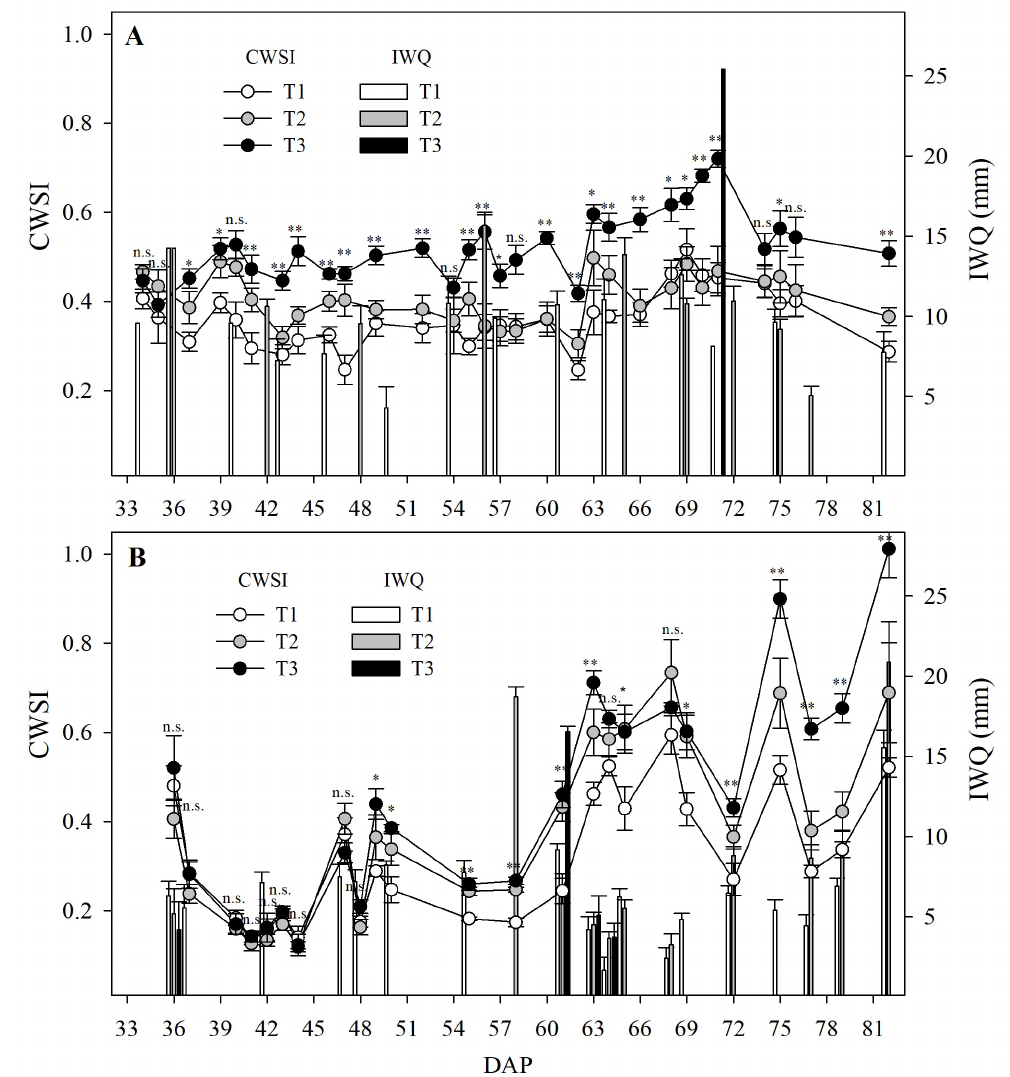
Figure 5. Average value ( ± standard error) of crop water stress index (CWSI, line chart) measured before irrigation treatments, and irrigated water quantity (IWQ, bar chart) for the first ( A ) and second ( B ) experiment for the three irrigation treatments: T1 (control or full irrigation), T2 (CWSI < 0.4), and T3 (CWSI < 0.7). The terms **, *, and n.s. indicate p < 0.01, p < 0.05, and p > 0.05 (not significant), respectively, in the ANOVA. DAP—Days after